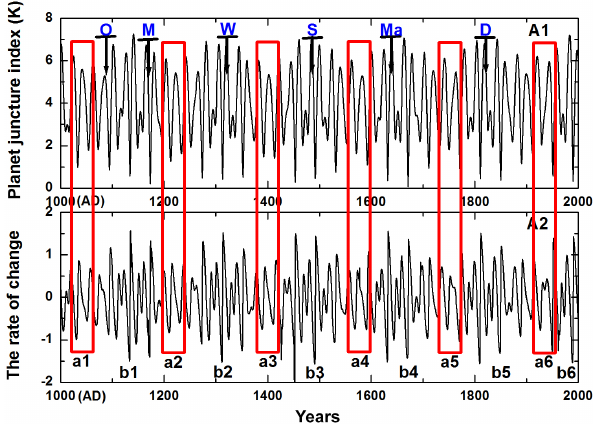
Figure 2. Planet juncture index and change rate of the planetary system’s mass center ( P ) orbiting the fixed point of the Sun ( S